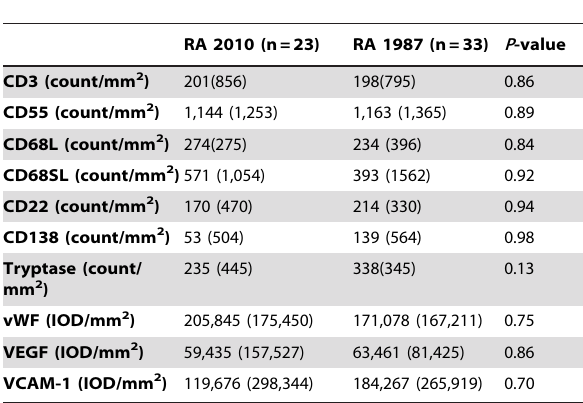
Table 2. Expression of synovial phenotypic and vascular markers in patients who fulfilled 2010 ACR/EULAR criteria for RA at baseline after follow up and in the patients who fulfilled1987 ACR criteria.